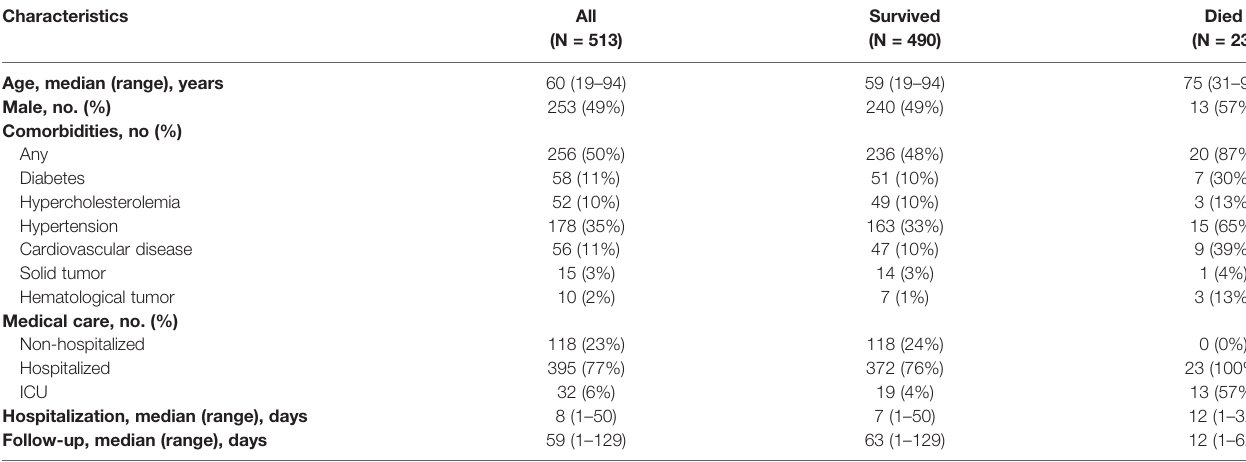
TABLE 1 | Demographics, comorbidities, and medical care received among COVID-19 patients, overall and according to disease outcome.